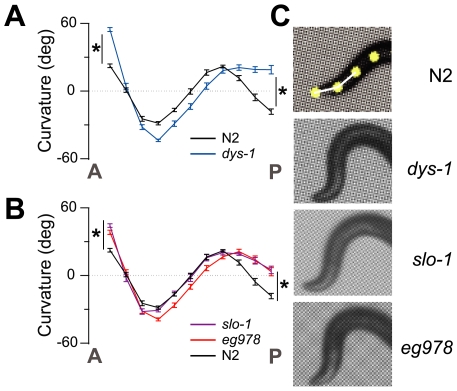
Locomotion analysis of wild-type and head-bending mutant animals.(A,B) Plots of average curvature values (angles) versus body position (11 positions) arranged anterior (A) to posterior (P). Asterisks indicate significantly deeper head bending than wild type (N2) for the first and 11th angles (P<0.05). We also observed significant difference in 11th angles between dys-1 and islo-1 (P<0.01). This difference may result from the phenotypic severity between dys-1 and islo-1 mutants. The genotypes of mutant animals are as follows: dys-1(eg33), slo-1(eg111) and islo-1(eg978). Error bars, SEM. (C) Representative photos show the anterior portion of wild-type and mutant animals. Yellow dots indicate the four most anterior of the 13 midline points for a wild-type animal. The first curvature angle is indicated in two white line segments.